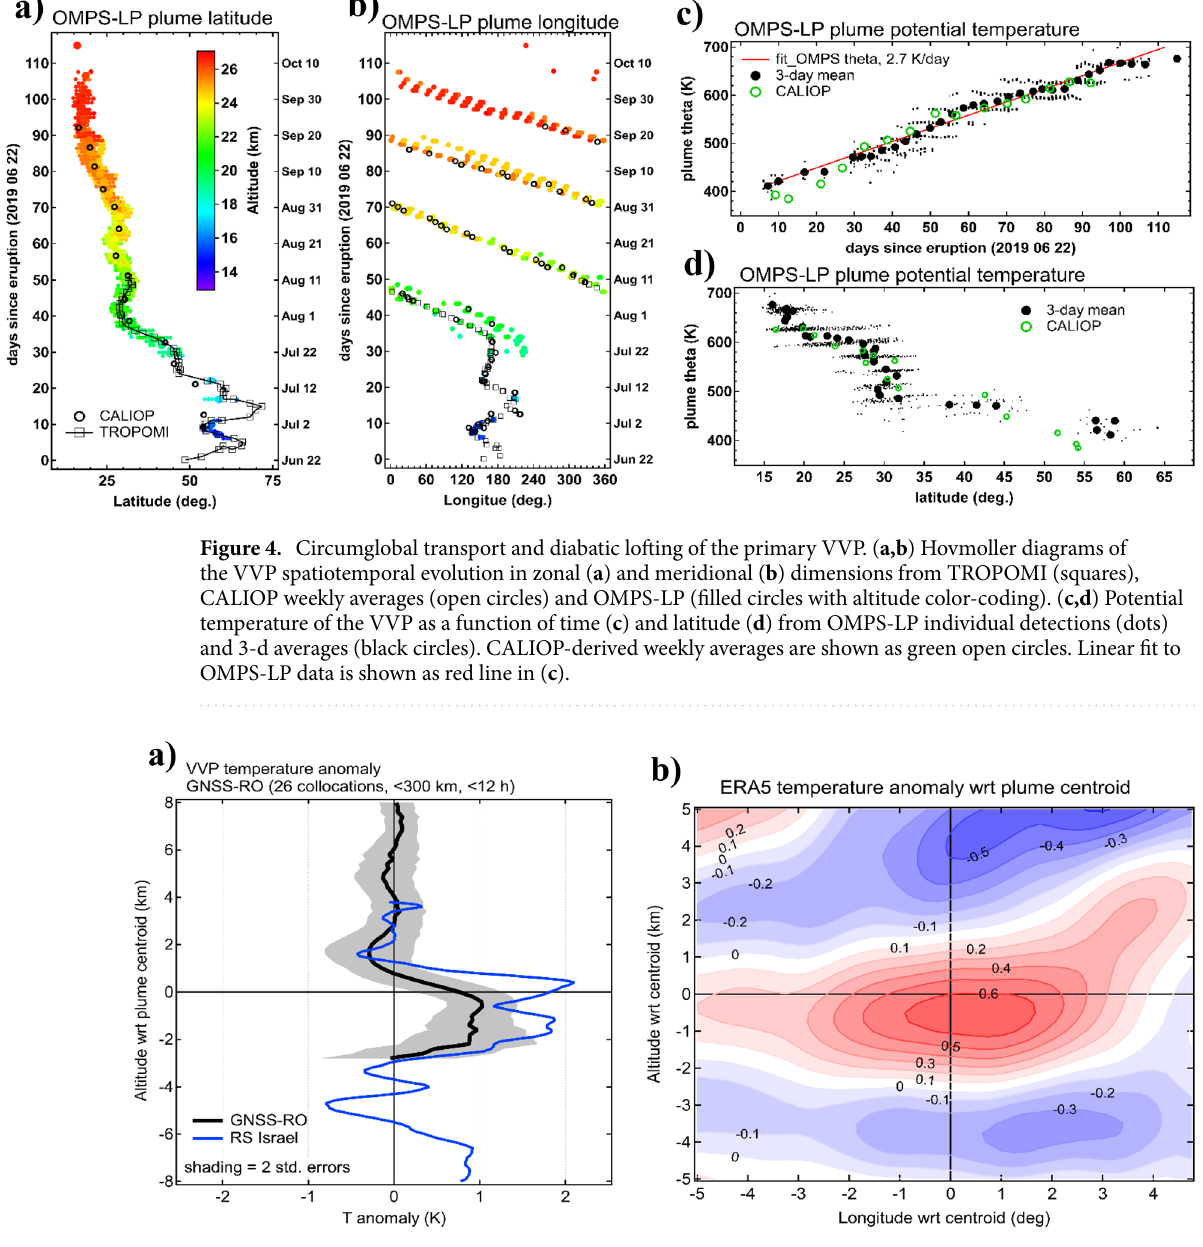
Figure 5. Internal heating of the VVP. ( a ) Composited temperature anomaly profile with respect to the aerosol plume centroid from 26 GNSS-RO measurement collocated with the plume during 25 July–10 August period. Grey shading represents two standard deviations. Blue curve shows the meteorological radiosounding from Bet Dagan station (Israel) that sampled the VVP on 5 August at 10 UTC (see Fig. S5). The temperature anomaly was computed with respect to 5-day average temperature profile. ( b ) Composited temperature anomaly in K from ERA5 reanalysis in the longitude-altitude plane with respect to the satellite-derived aerosol plume centroid. The composite is based on the data between 25 July and 10 August, that is when the vortex for overpassing above Asia and Africa for the first